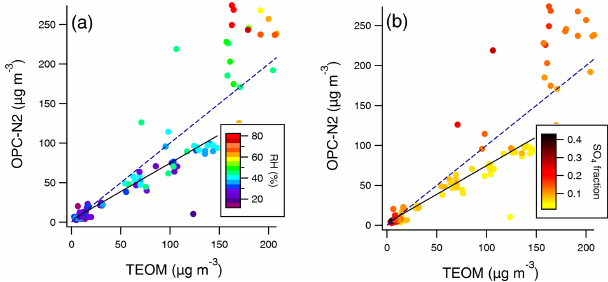
Figure 1. Plot of the reported PM 2 . 5 mass concentration from the OPC-N2 against ambient RH for the whole measurement period in Delhi (a) , Nairobi (b) , Beijing (c) , Bham BAQS (d) , Nicaragua (e) and Bham Tyburn (f) . Note the different y and x axis scales.